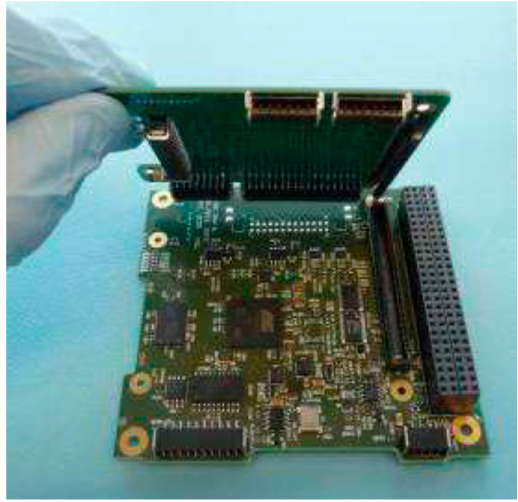
Figure 37. ISIS On-Board Computer [58].